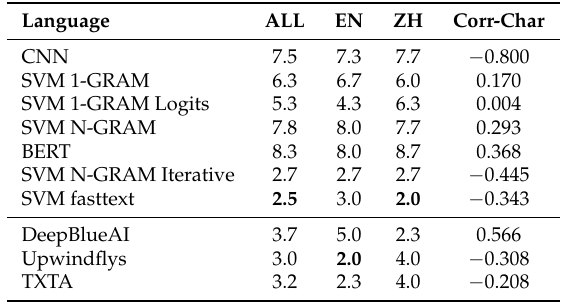
Table 11. Text: Average rank over ALC, for all datasets and per language; Corr-char: correlation between rank and average number of characters per